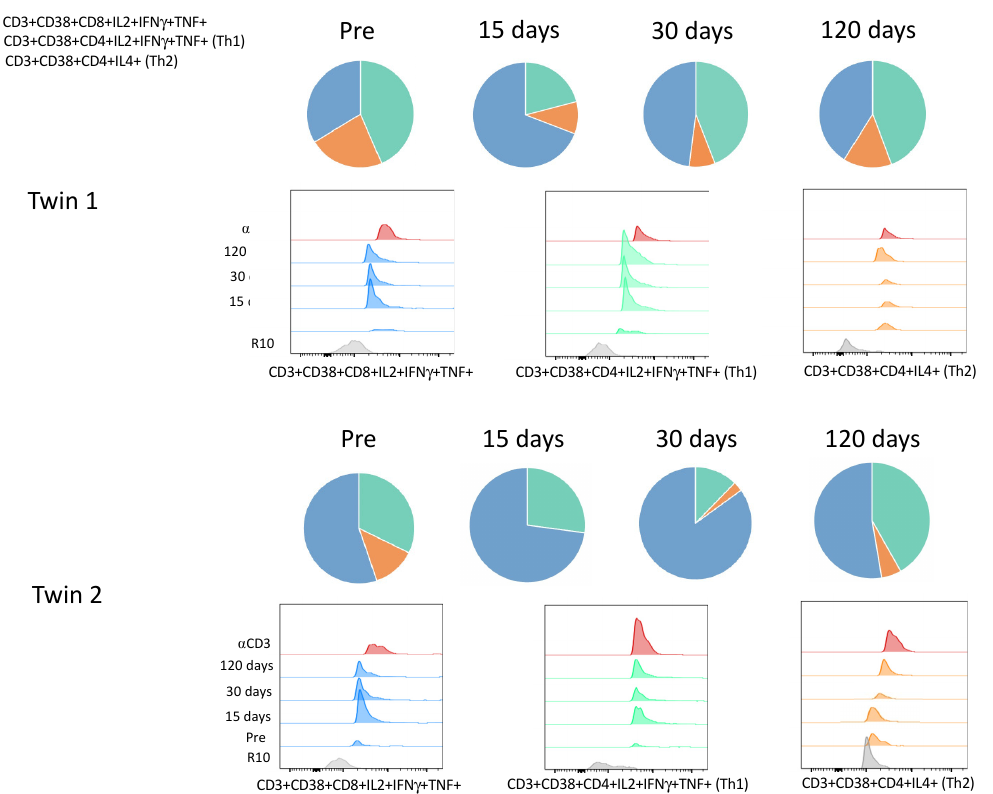
Figure 3. Cytokines production by CD4+ and CD8+ T lymphocytes. The pie charts show the distribution of cytotoxic CD8+ T (CD3+CD38+CD8+IL2+IFN γ +TNF+), CD4+ Th1 (CD3+CD38+CD4+IL2+IFN γ +TNF+), and CD4+ Th2 (CD3+CD38+CD4+IL4+) cells upon spike glycoprotein stimulation after vaccination for the twins over time. The histograms from FACS analysis show the expression of those cell profiles. R10: RPMI 1640 medium used as negative control for cell cultivation, α CD3: anti-CD3 monoclonal antibody used as positive control for cell cultivation. Pre: samples collected before the 1st dose of AstraZeneca COVID-19 vaccine, day 0.